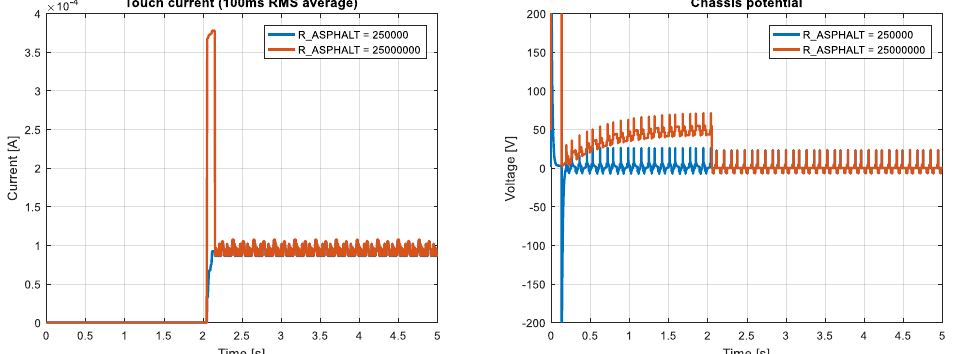
Figure 3. Touch current (100 ms RMS average) ( left ) and chassis potential ( right ) during normal operation.